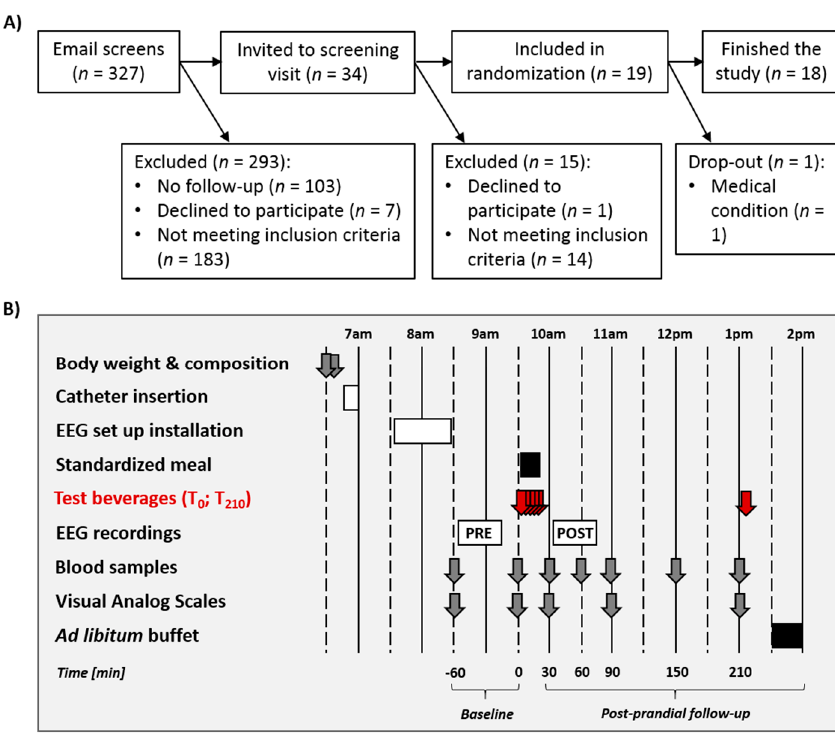
Figure 1. ( A ) Flow diagram for study participants’ eligibility, enrollment, and follow-up. ( B ) Detailed protocol of the in-center test days. Identical procedures were used on the three test days. Test beverages (WAT, SUC, NNS) were ingested at T = 0 min (350 mL; five 70 mL-glasses every 5 min) and at T = 210 min (one 200 mL glass). EEG: electroencephalographic recording session.